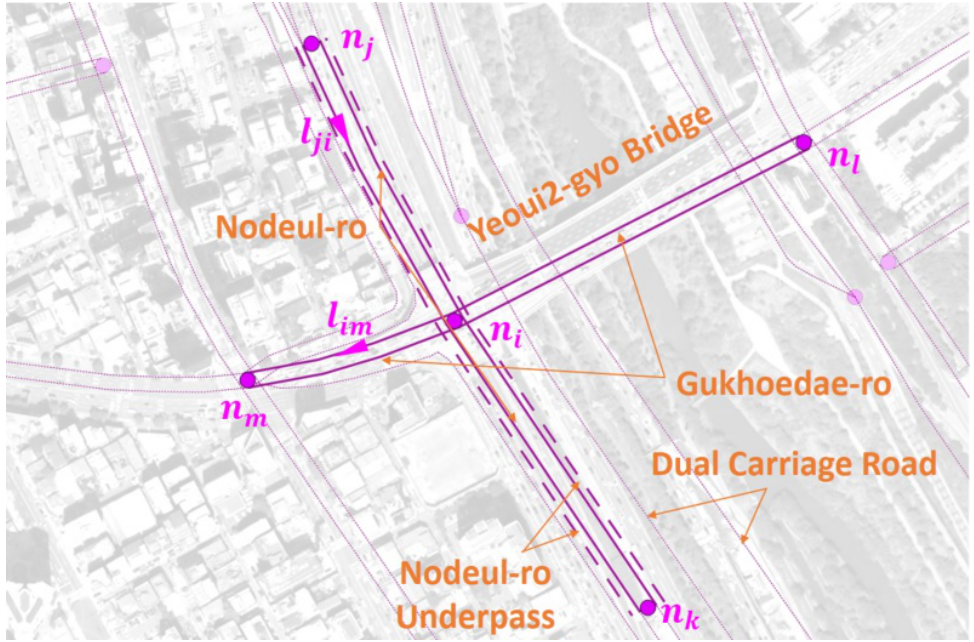
Figure 1. NLM graph representation around Yeoui2-gyo